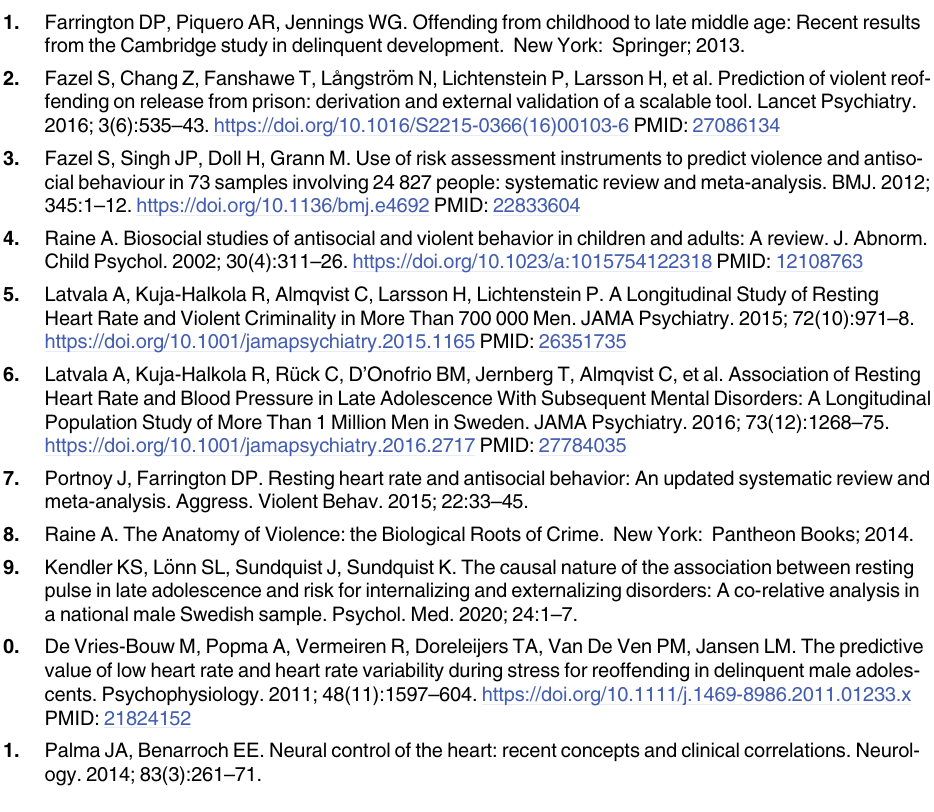
S2 Fig. Kaplan Meier survival curves for reoffending as any conviction by quintiles of SBP.